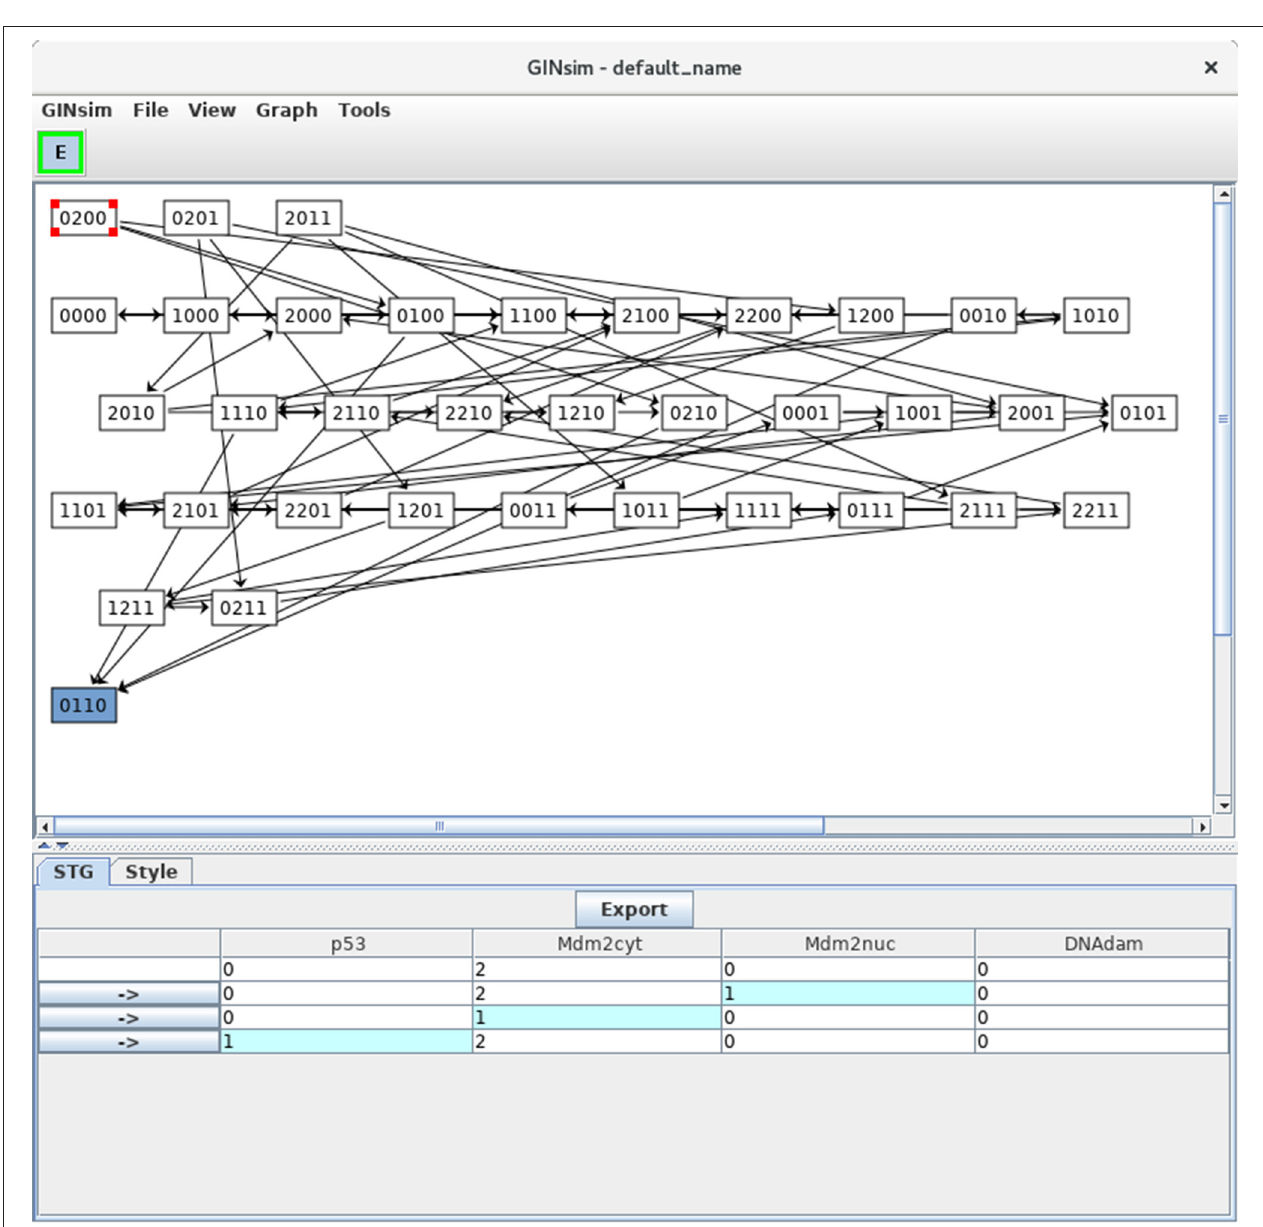
FIGURE 6 | Asynchronous state transition graph for the p53-Mdm2 model. This STG has been generated with the simulation parameters shown in Figure 5 . The unique stable state 0110 lays at the bottom. The selected state 0200 is shown in the STG tab, with its successors.